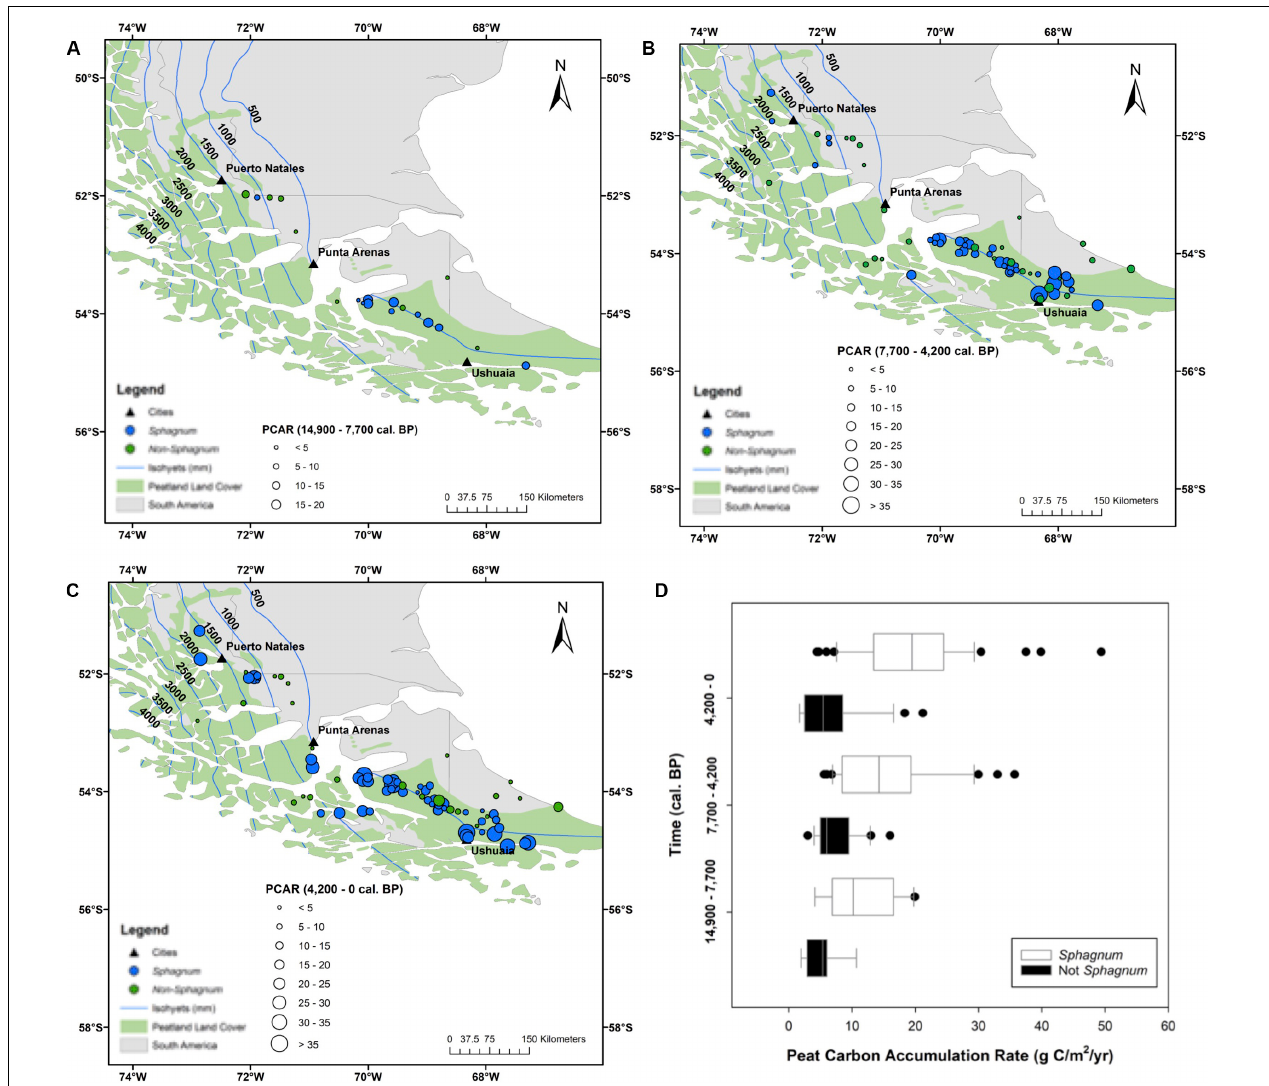
FIGURE 6 | A comparative analysis of Sphagnum vs. non- Sphagnum peat-carbon accumulation rates (PCAR) over time. (A–C) Spatial distribution of Sphagnum (blue circles) and non- Sphagnum (in green) peatlands and associated PCAR (circle size). (D) Temporal distribution of PCAR changes between Sphagnum (white boxes) and non- Sphagnum (black boxes) peat types. The time periods are dictated by three tephra layers: Reclus I (14,900 cal. yr BP), Hudson I (7700 cal. yr BP), and Burney II (4200 yr cal. BP). Sphagnum and non- Sphagnum peat masses are statistically different for every time period (Tukey’s HSD: p < 0.001), except from 14,900 to 7700 cal. yr BP. The peatland area is from Yu et al. (2010) and the dataset used to generate the isohyets is from New et al.